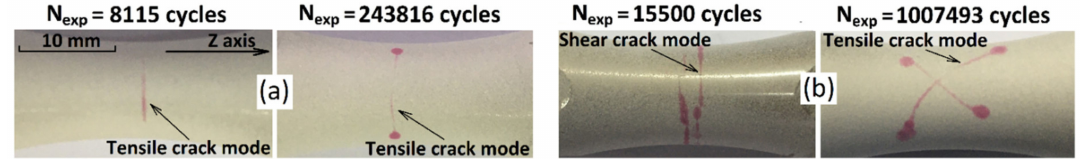
Figure 6. Exemplary photos of fatigue cracks under cyclic ( a ) bending and ( b ) torsion loads for the S355